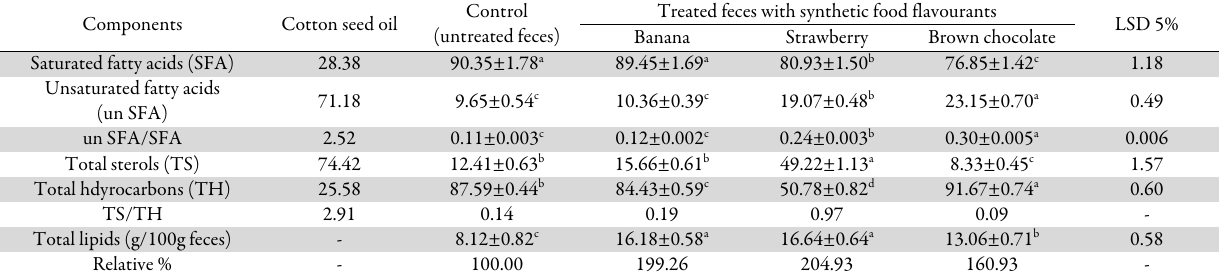
Table 4. Effect of synthetic food flavourants on total lipids, saturated, unsaturated fatty acids, sterols and hydrocarbons of rat feces